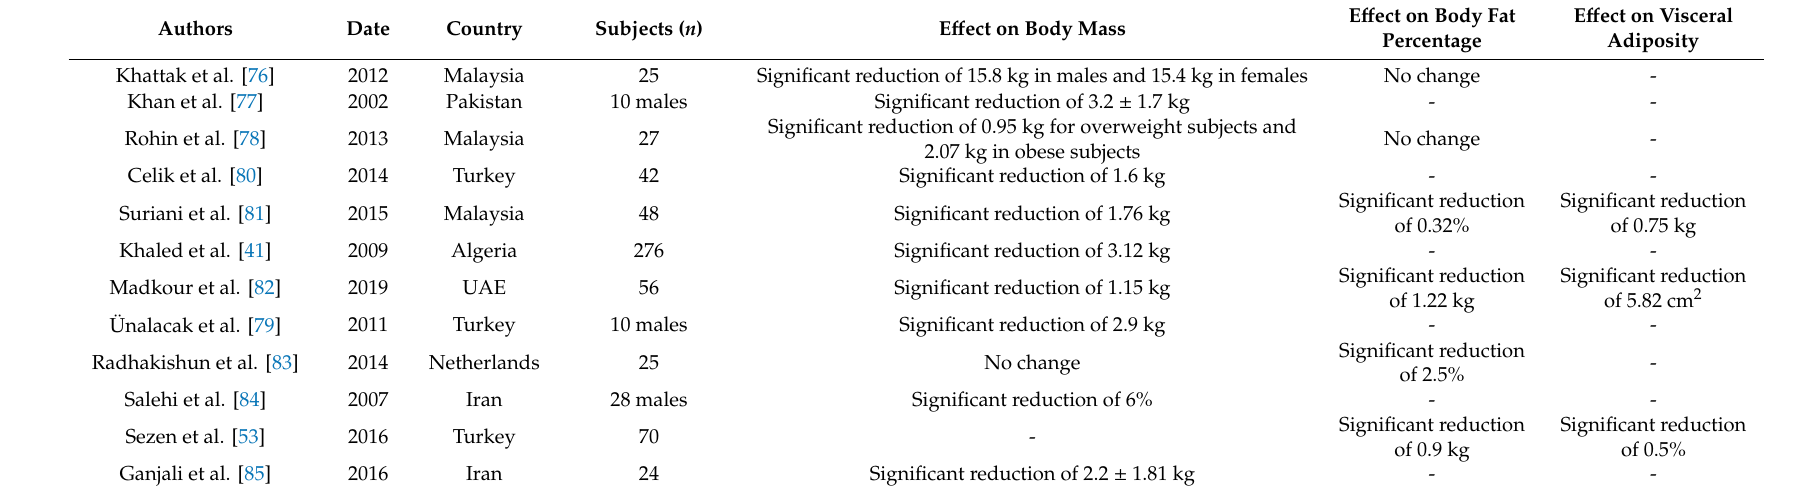
Table 4. E ff ect of Ramadan fasting on body mass, body fat percentage and visceral adiposity of overweight and obese